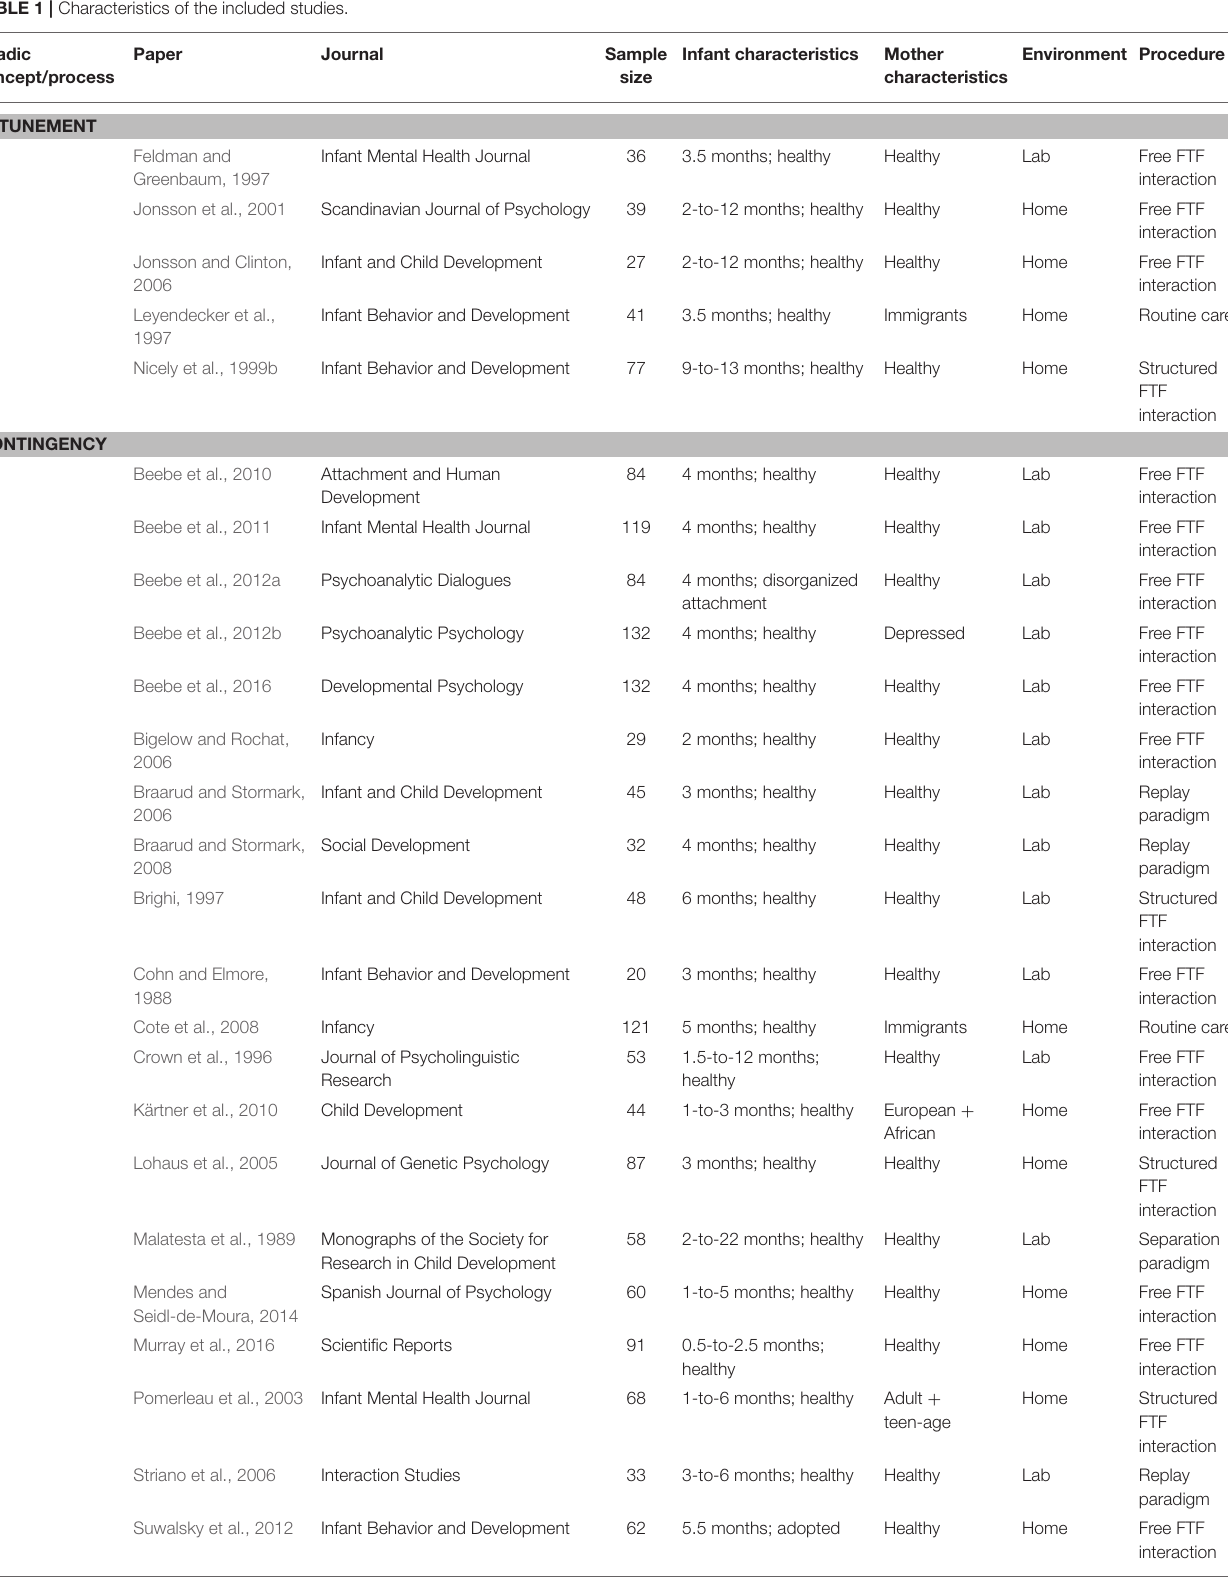
TABLE 1 | Characteristics of the included